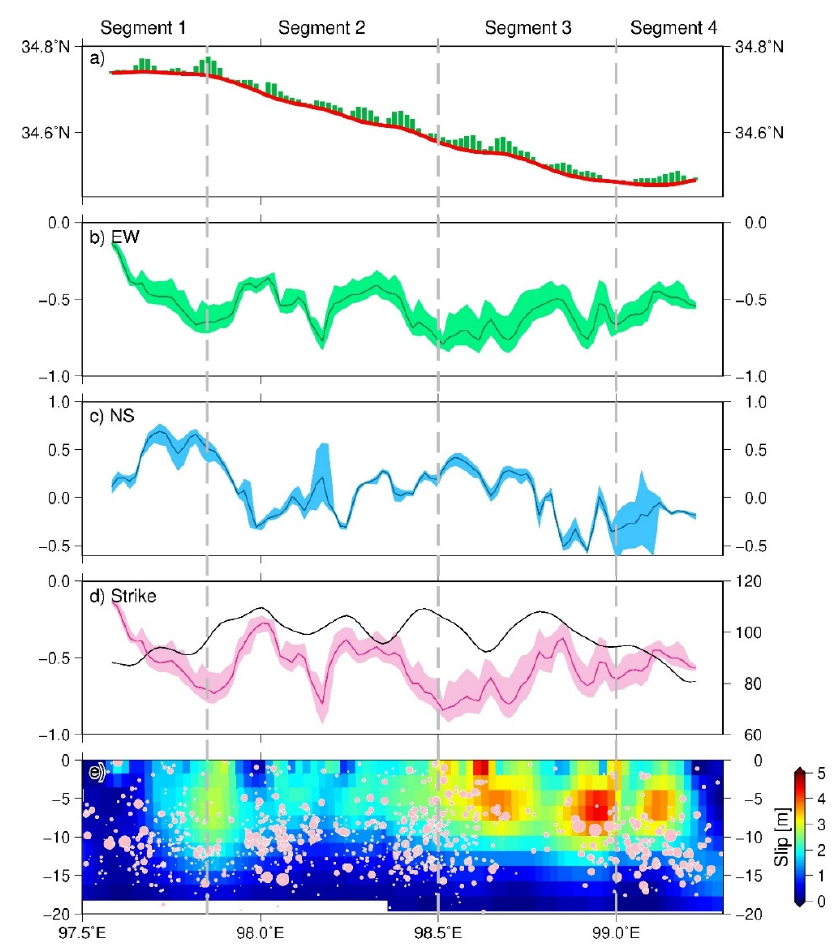
Figure 7. ( a ) Surface rupture traces of the Maduo earthquake detected from InSAR deformation fields (red line) and its curvature (green bars). We only use the magnitude of fault curvature to show the local variations of fault strike. ( b – d ) Coseismic displacement offsets in east-west (positive for the east direction), north-south direction (positive for the north direction). and fault-strike parallel (positive for right-lateral strike slip) direction. The colored lines represent the mean values using different numbers (30–100) of surrounding points in the calculation, and the colored band is 95% confidence interval. Black line indicates the strike angle along fault. ( e ) Inverted coseismic slip distributions on the fault plane with aftershocks marked by pink